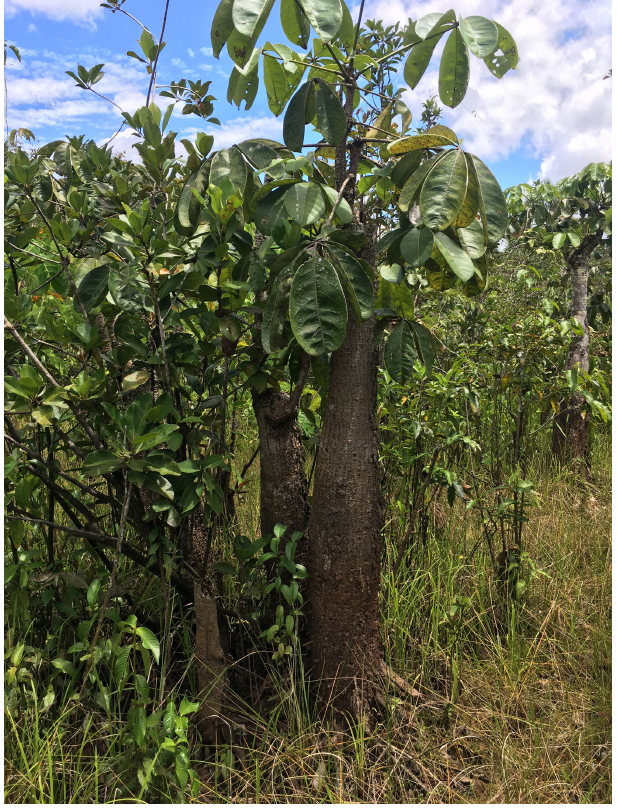
Fig. 3 . An alaka ; this ecosystem is defined by the mix of large trees and palm trees, as well as the permanently waterlogged peat